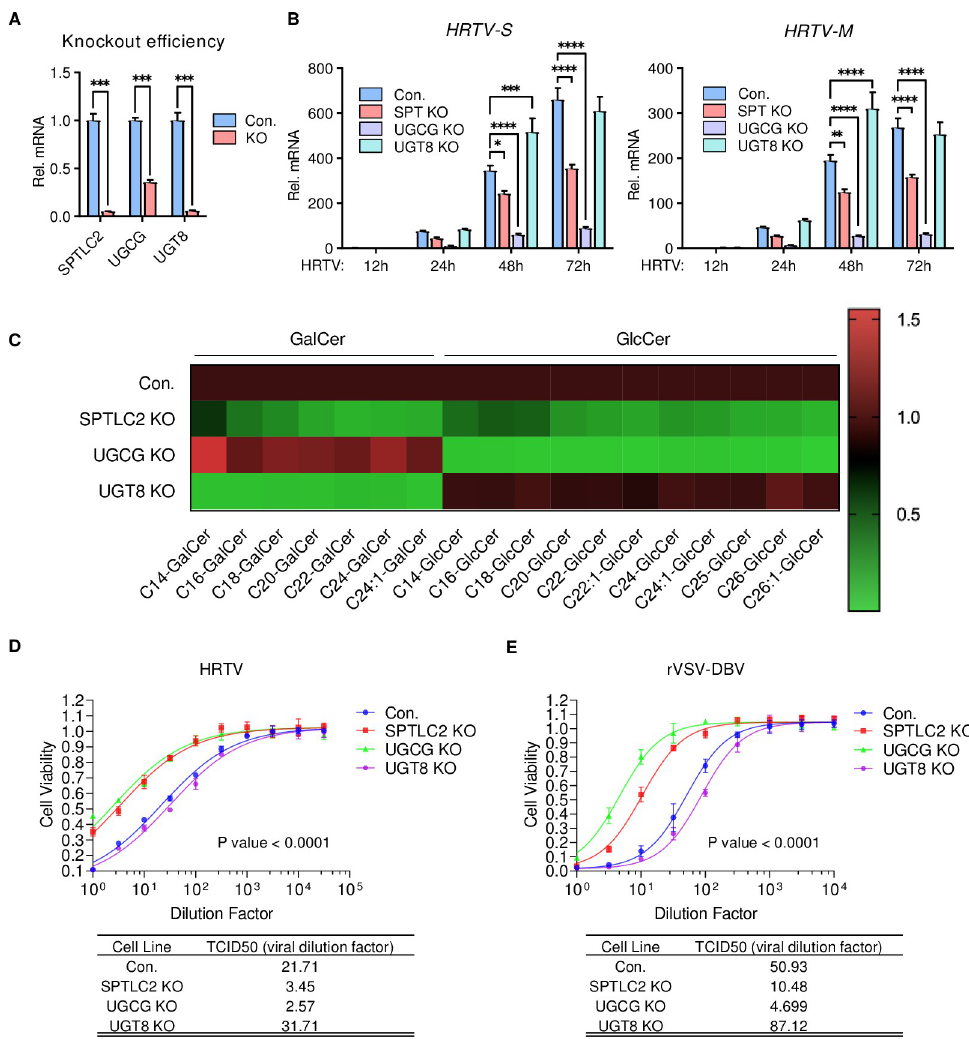
Fig 3. HRTV requires GlcCer for efficient infection. A-B. Effect of SPTLC2-, UGCG- or UGT8-deficiency on HRTV replication. Control and KO 293T cells were infected with HRTV (MOI = 1) for the indicated times for qPCR analysis. Knockout efficiency of SPTLC2- , UGCG- or UGT8 gene was measured by qPCR. Data shown are means ± SEM from representative experiments (n = 3 technical replicates). P values were determined by multiple unpaired t -tests ( A ) or two- way ANOVA with Dunnett’s multiple comparison tests ( B ). ���� , P < 0.0001; ��� , P < 0.001; �� , P < 0.01; � , P < 0.05. C. Heat map of the levels of intracellular GalCer and GlcCer in SPTLC2-, UGCG-, or UGT8-deficient 293T cell lines. D-E. TCID 50 of HRTV and rVSV-DBV in control, SPTLC2-, UGCG-, or UGT8-deficient 293T cells. Half-log serially diluted HRTV or rVSV-DBV was added to 4 replicate wells of a 96-well plate for 72 hours before luminescence